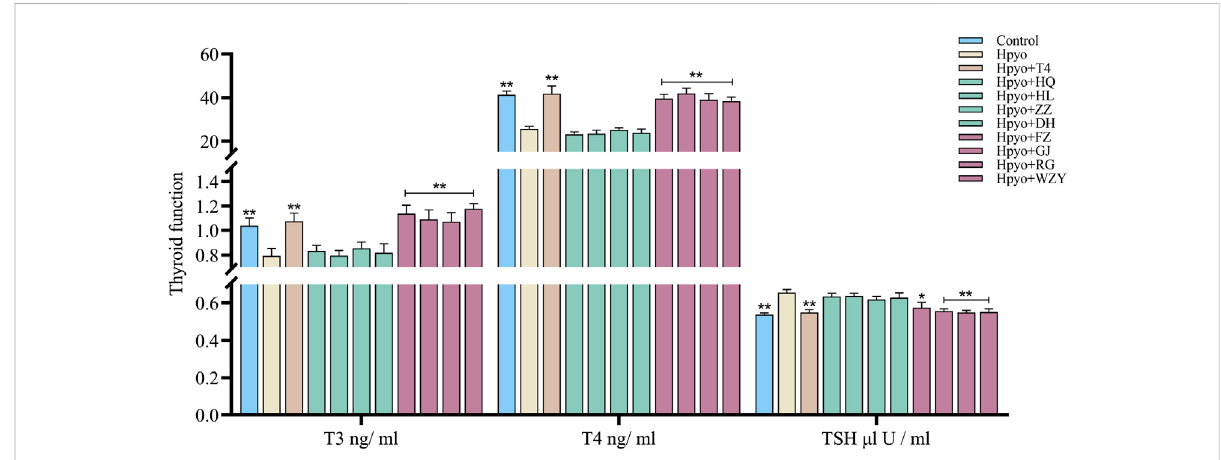
Effects of the four typical “ hot ” property herbs and the four typical “ cold ” property herbs on the thyroid function of the hypothyroidism model ( n = 8). Note: Compared with the model group, * p < 0.05, ** p <